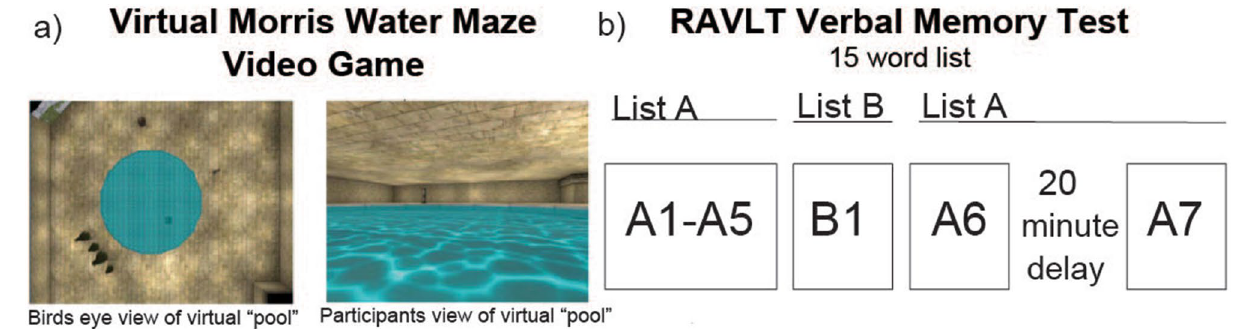
Figure 1. Spatial and verbal memory tasks. ( a ) Snapshots of the virtual Morris Water maze task 57 , including a view of the virtual pool the participant navigates in. Similar to the animal Morris Water Maze Task, participants were asked to navigate through the virtual pool using a joystick to find a hidden platform. Permission to use screenshots from this task was granted by Dr. Moffat 57 . ( b ) Sequence of the RAVLT memory task.